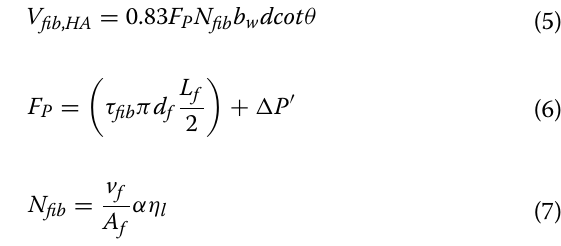
where k f denotes the factor taking into account the con- tribution of the beam section, h f denotes effective depth of the section, b f denotes width of the flanges, b w denotes width of the web, k l is equal (1600-d)/1000 and greater than or equal to 1, and τ fib denotes the design value of the increase in shear strength due to steel fibers (0.12 f eqk , 3 ). Aoude et al. (2012) suggested a prediction equation of shear strength resistance with respect to the contribu- tion of steel fibers ( V fib,HA ) that is related to the pullout strength of the fibers crossing cracking plane and fibers randomly oriented in three dimensions. Additionally, a crack inclination θ of the SFRC beam was considered under the free body diagram. Thus, the V fib,HA was calcu- lated as